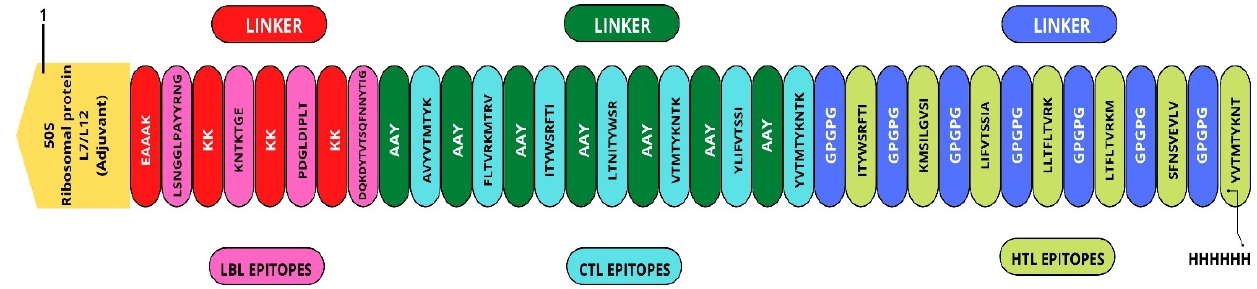
Figure 5. Multi-epitope vaccine construct.